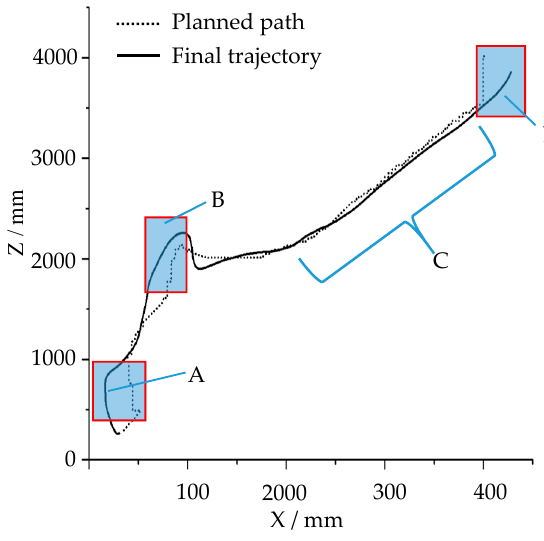
Figure 34. The planned path and final trajectory of the robot in the navigation simulation.